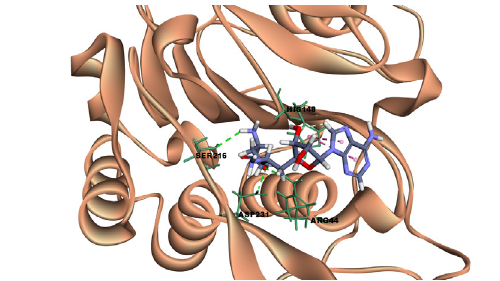
Fig. 5B. 3D diagram showing interactions of sine- fungin at LGMN catalytic site.